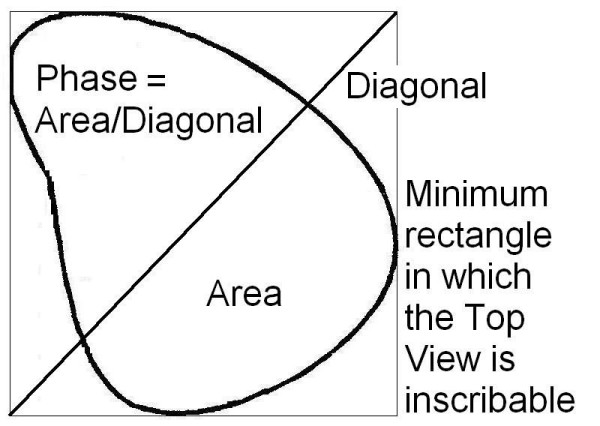
The classificatory parameter defined Phase is the Top View graphical representation of the 3D spatial evolution of the curve as reported in Figure 4. This parameter is obtained dividing the spinal area for the diagonal of the minimum rectangle in which the Top View is inscribable. This allows to verify mathematically how much is "open" the curve considered: the highest value is reached with a circle (anisophasic curve, according to our definition), the lowest with a line (isophasic curve, according to our definition).